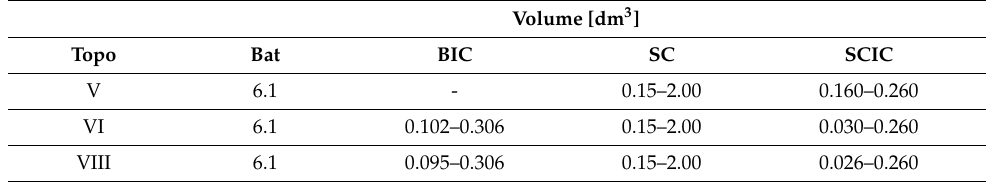
Table 19. Comparison of estimated volumes of batteries, super-capacitors, BIC, and